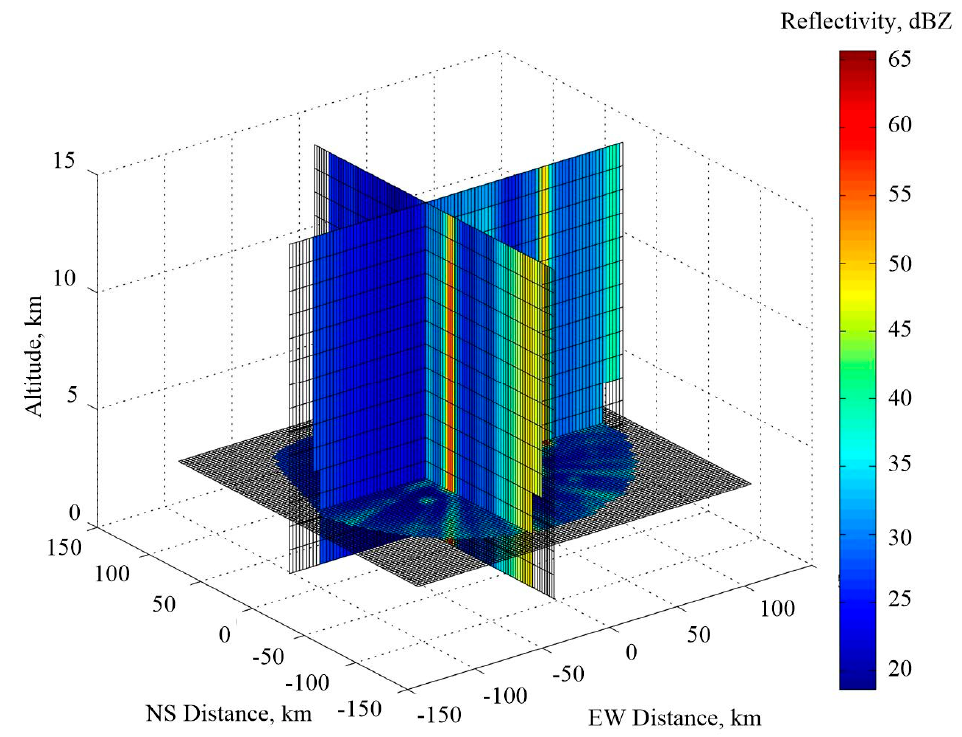
Figure 18. Description is the same as in Figure 16, except for the relevant positive lightning leader onset indicated by Case #7 and slicing cross-section planes that are forward through the point in- dicated by coordinates: x = − 21.7 km, y = − 0.3 km, z = 3.3 km.